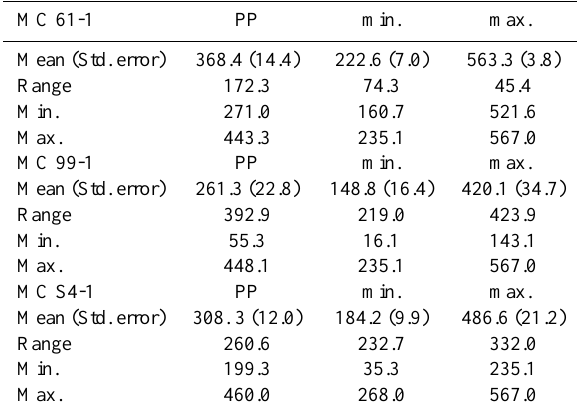
Table 4. Descriptive statistics of MAT reconstructions of annual primary productivity (confidence level of 95%); standard errors for the mean values (Std.e.) are given in